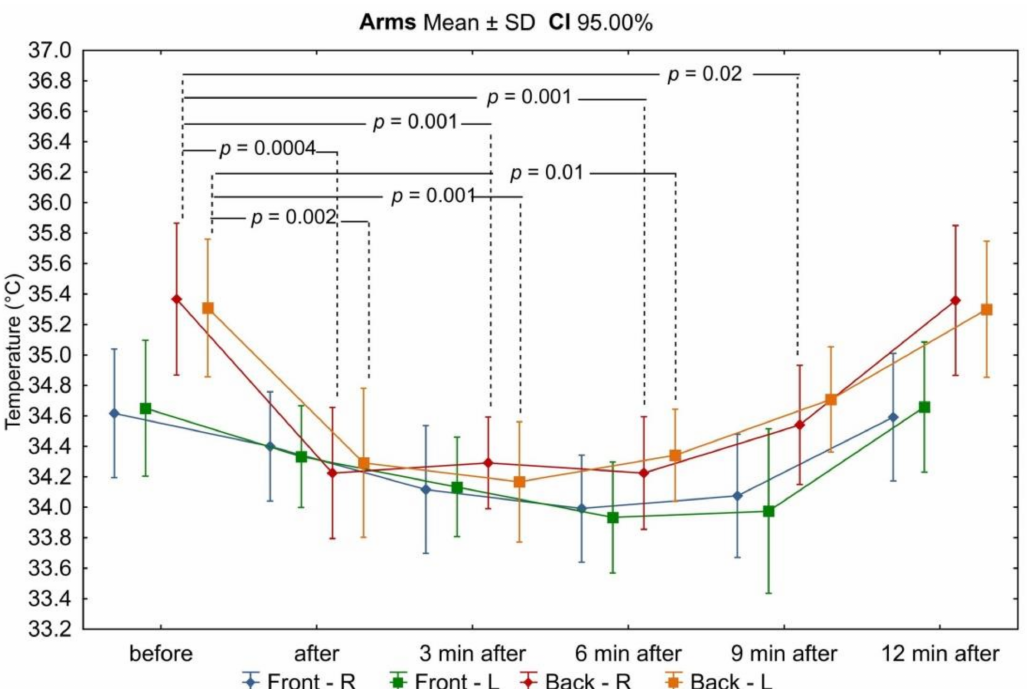
Figure 2. Dynamics of changes in the mean values of the surface temperature of the arms during successive measurement points before and after the exercise test. Legend: test probability level determination for Tukey’s RIR post hoc tests. Data are expressed as mean with standard deviation.